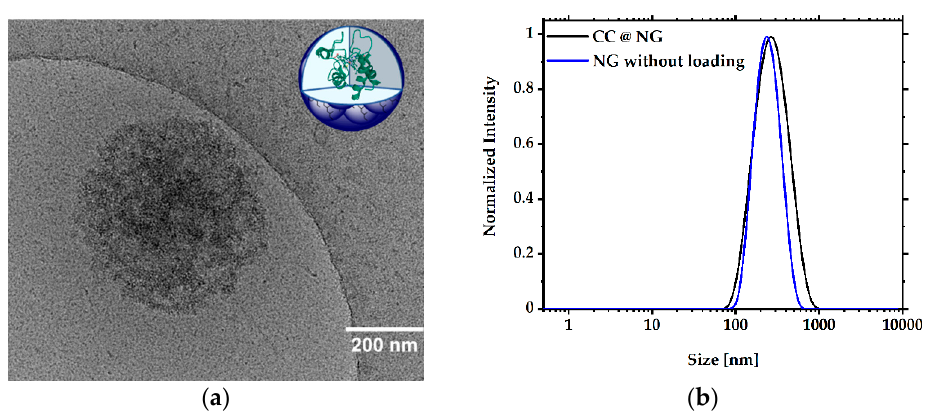
Figure 3. Characterization of cytochrome C-loaded NGs (CC@NGs). ( a ) Cryo-TEM image of CC@NGs with a scale bar of 200 nm. The full cryo-TEM is depicted in Figure S4. ( b ) Size distribution curves of CC@NGs (black) compared to free nanogel (NG) (blue) measured by DLS. Table 2. Analysis of cytochrome C-loaded NGs.